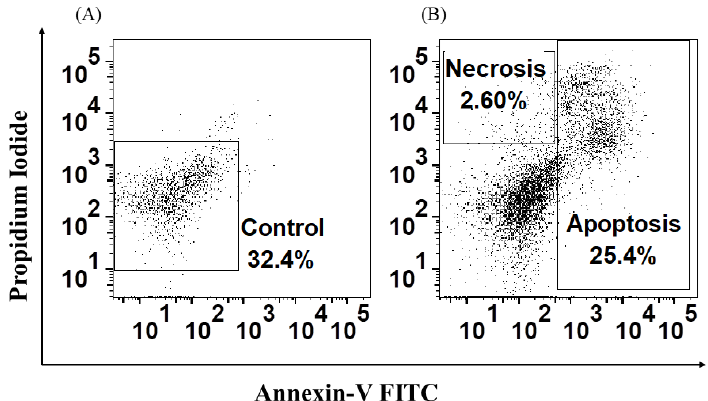
Figure 6. Histoplasma capsulatum induces apoptosis and necrosis in HSPC. HSPCs were treated with Annexin V-FITC and propidium iodide as described in materials and methods. ( A ) Control, uninfected HSPC; ( B ) HSPC stimulated with H. capsulatum yeasts. Percentages represent the number of cells positive for FITC and propidium iodide. Similar results were obtained from three independent experiments.